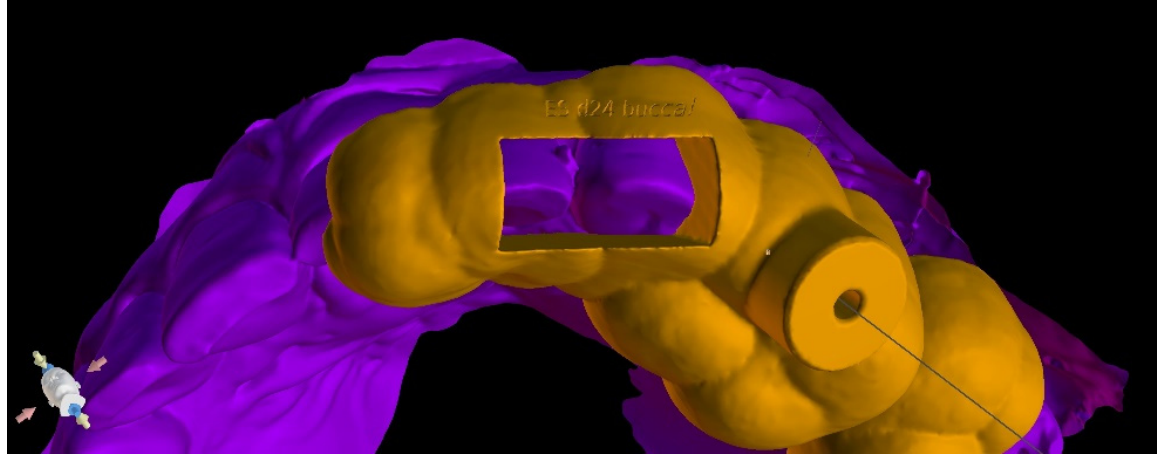
Figure 27. Image presenting guide with window on the occlusal site that allowed us to check the correctness of the endodontic guide placement.